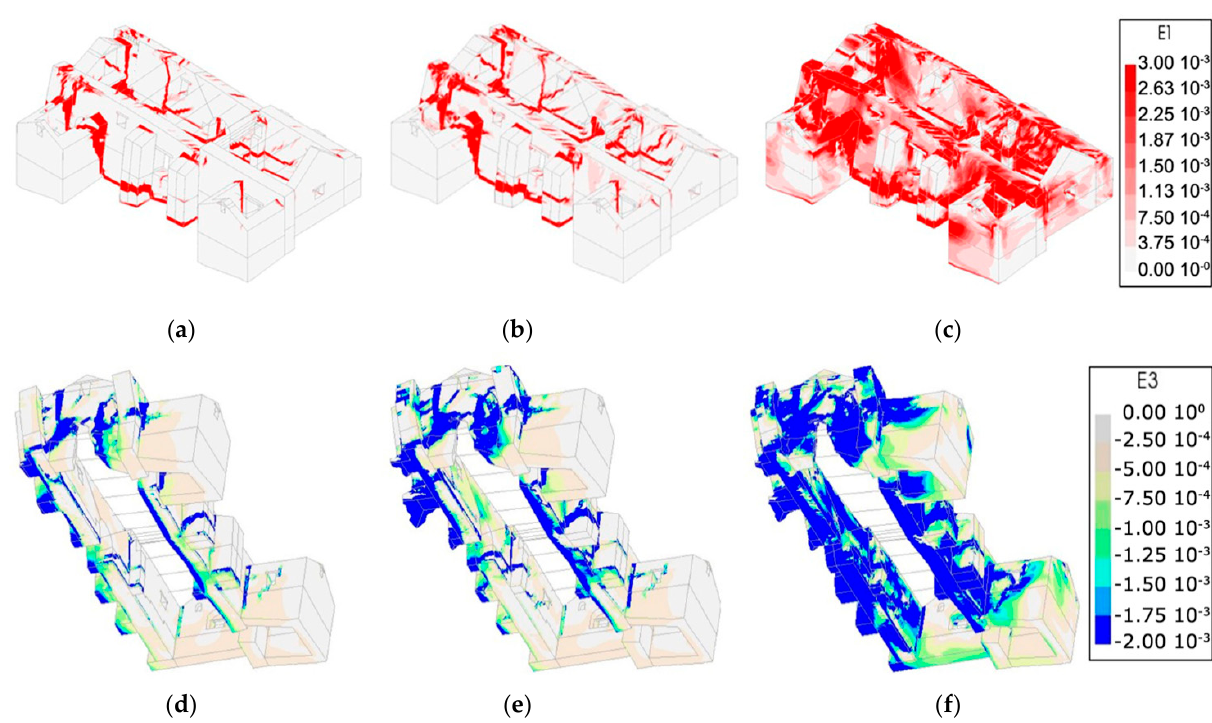
Figure 21. Distribution maximum principal strain in +YY direction at the ultimate stage of ( a ) NTC 2018, ( b ) KADET 2021 and ( c ) ASCE41-13. Distribution minimum principal strain in +YY direction at the ultimate stage of ( d ) NTC 2018, ( e ) KADET 2021 and ( f ) ASCE41-13.